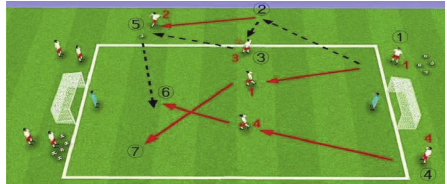
Figure 2: Tactical simulation